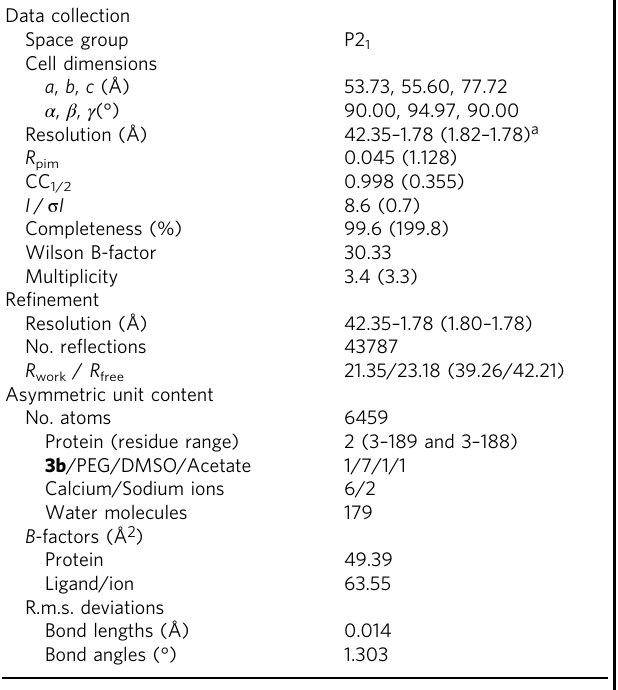
Table 1 Diffraction data collection and re fi nement statistics Data collection Space